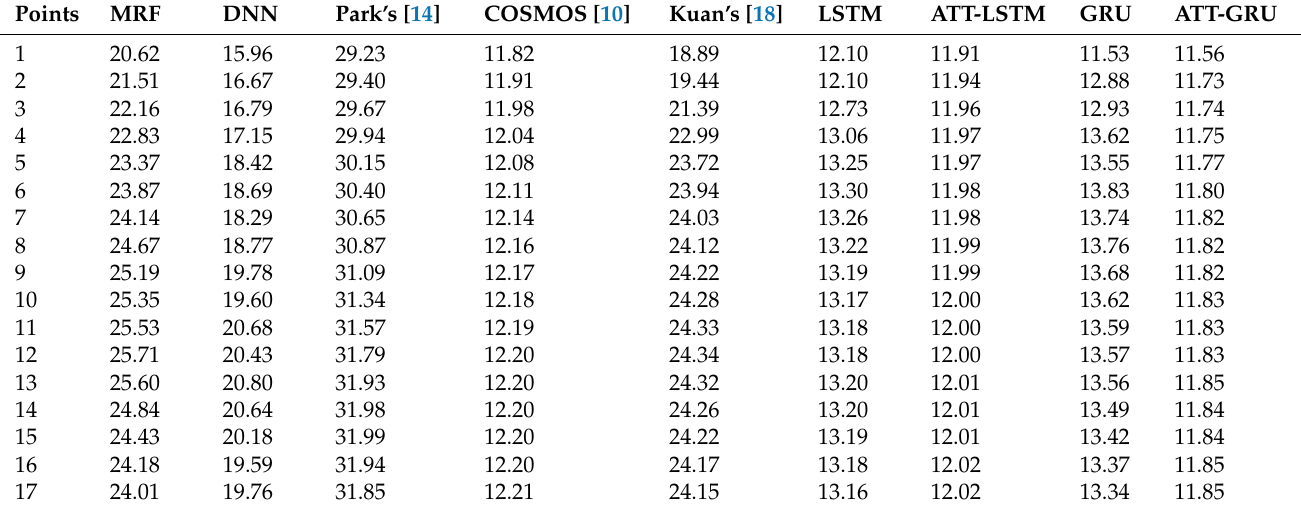
Table A2. Mean absolute percentage error comparison for Building